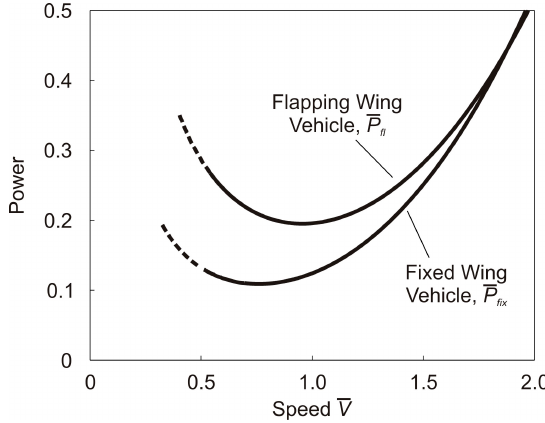
k , 9.0 = η ). flap prop